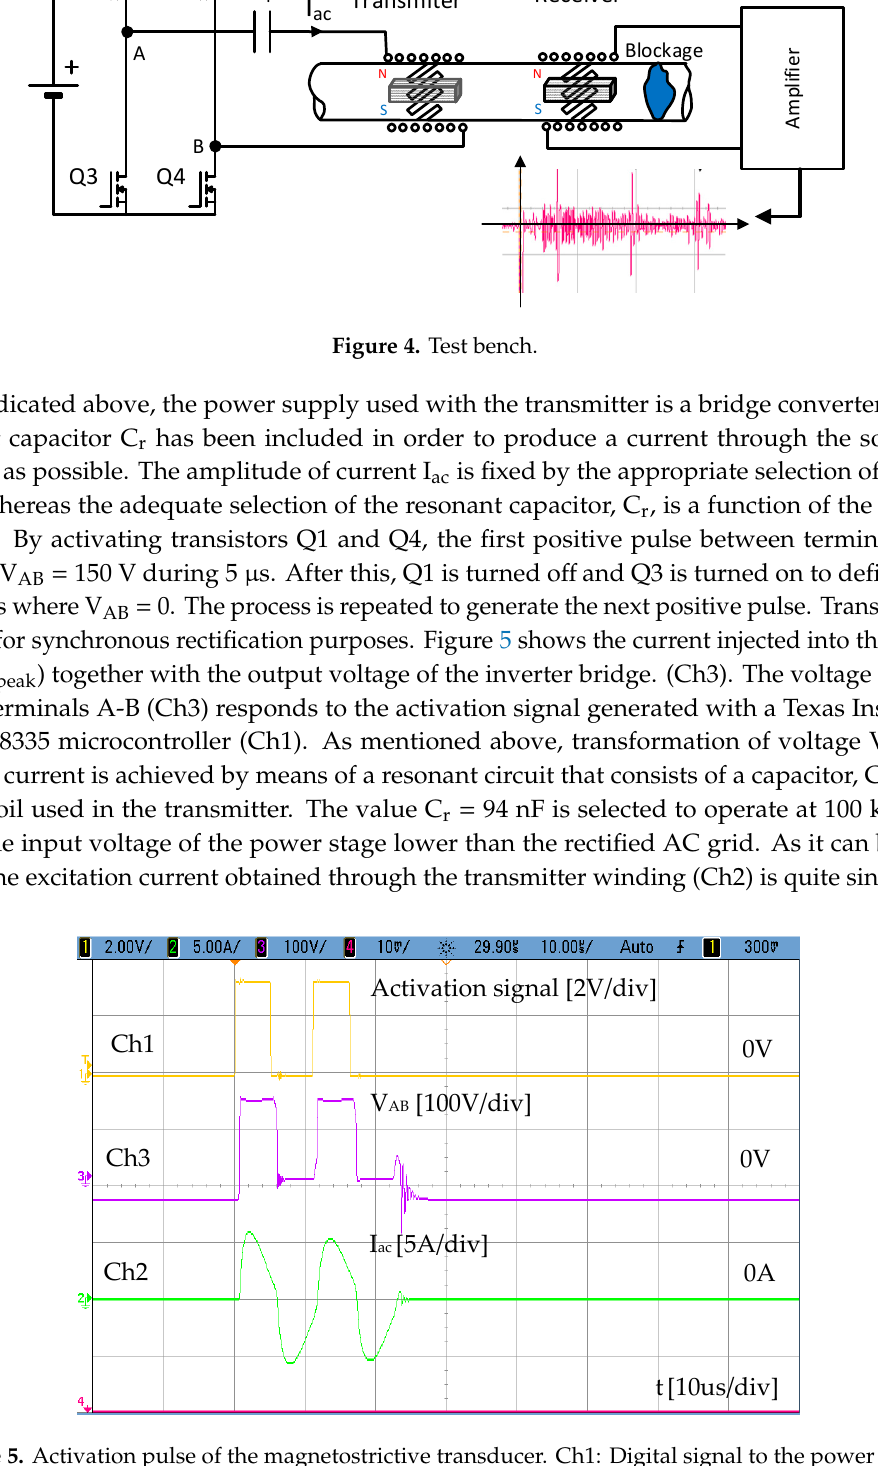
Figure 5. Activation pulse of the magnetostrictive transducer. Ch1: Digital signal to the power stage, Ch2: current through the AC coil, Ch3: Voltage at the resonant circuit.